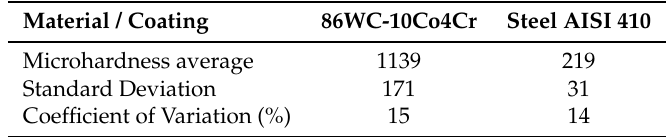
Figure 8. cross-section (500 × ). Table 3. Results of Vickers microhardness measurements—cross-section